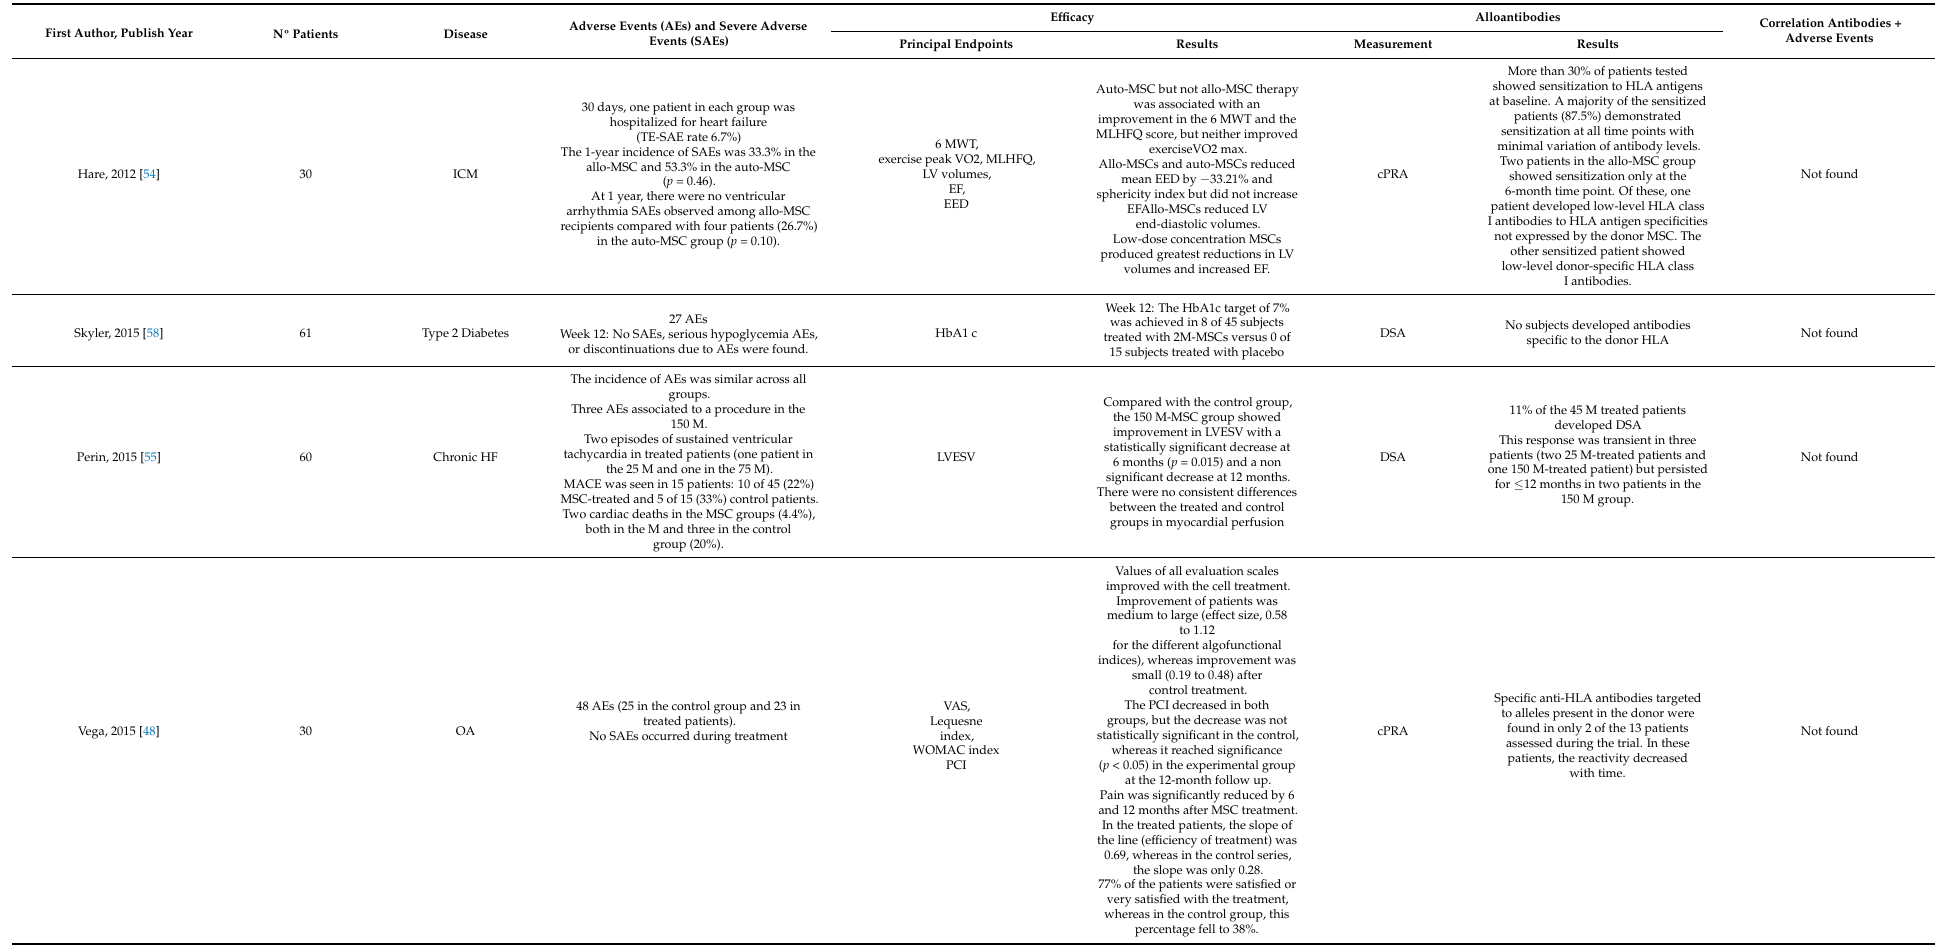
Table 3. Summary of the efficacy and adverse events associated with the generation of alloantibodies by Mesenchymal Stromal Cell